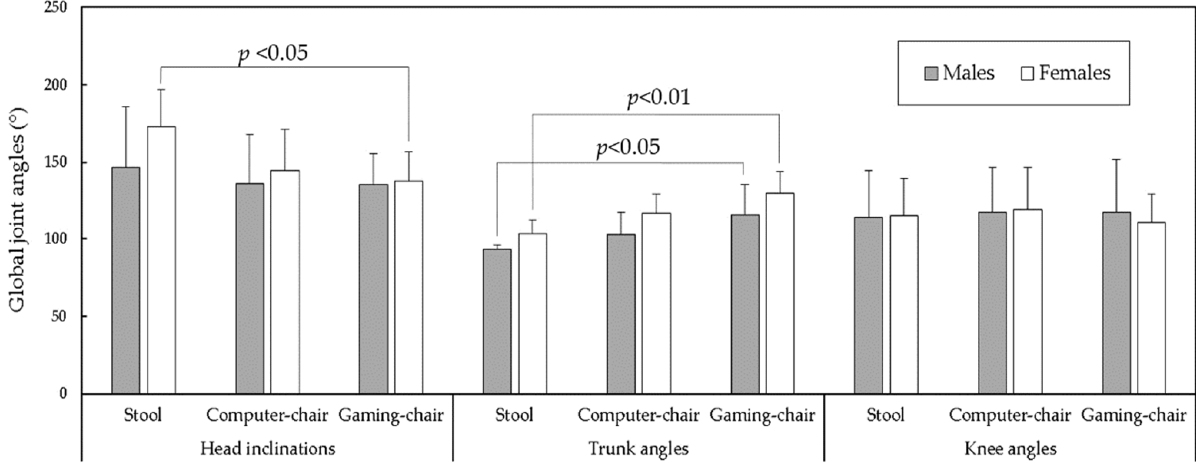
Figure 2. Comparisons of mean joint angles for various test combinations and the Duncan MRT test results.